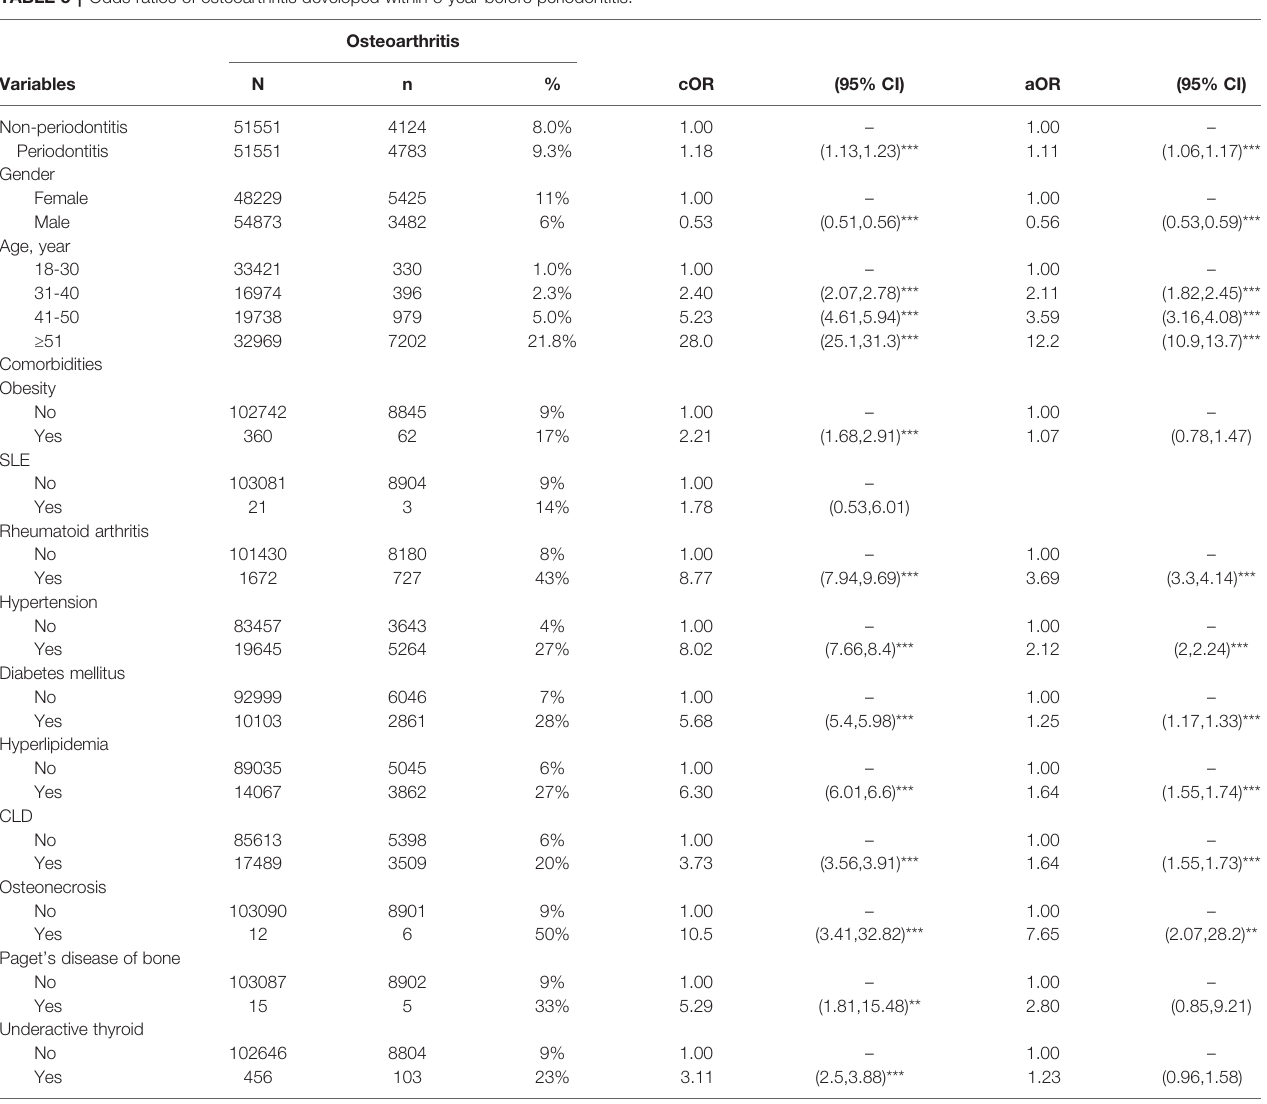
TABLE 5 | Odds ratios of osteoarthritis developed within 5 year before periodontitis. Osteoarthritis